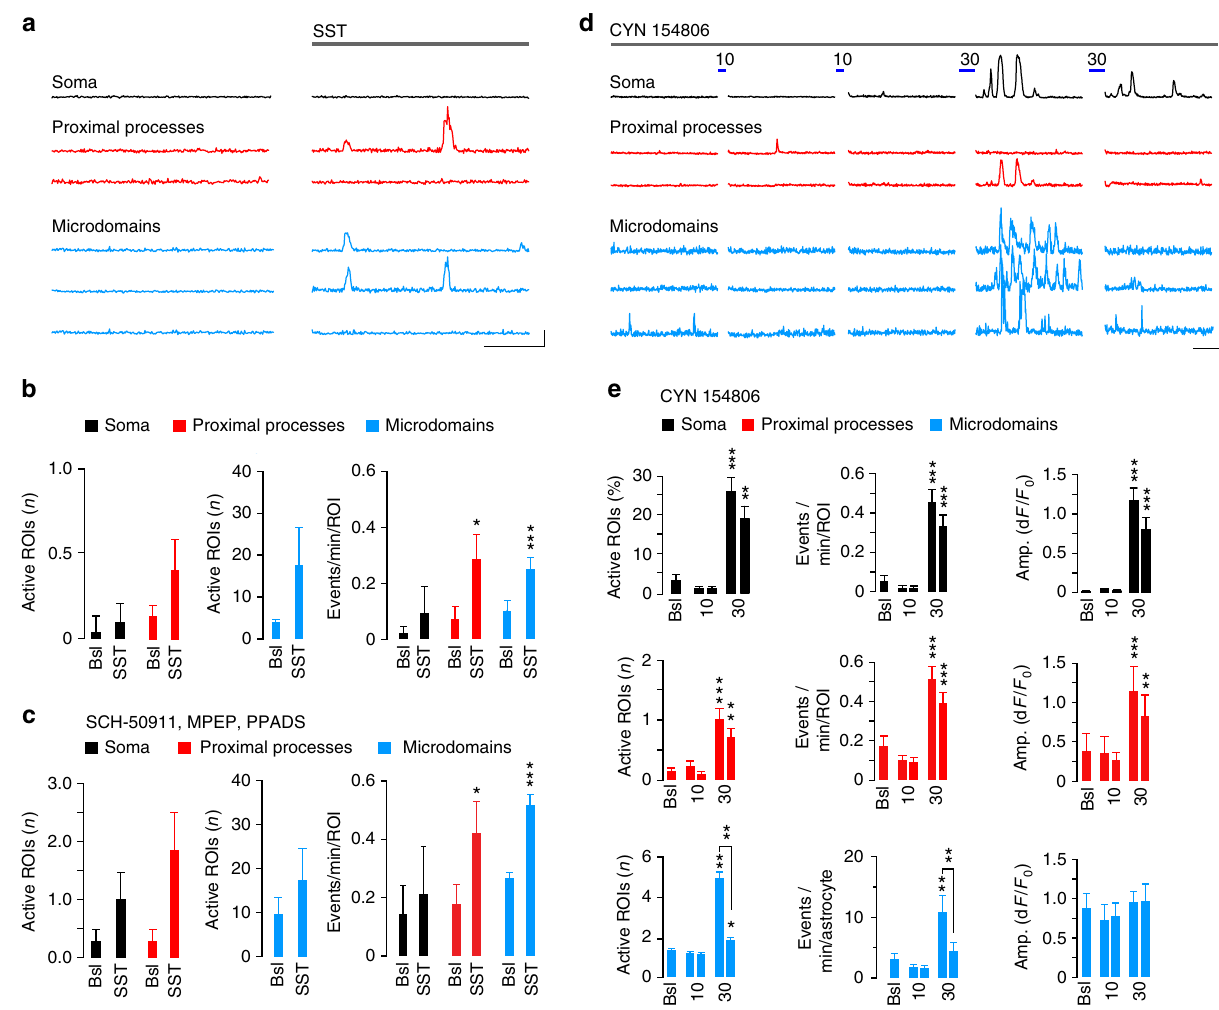
Fig. 6 SST interneuron signaling speci fi city to astrocytes depends on the neuropeptide somastostatin. a Representative traces and b , c quantitative evaluation of GCaMP6f-astrocyte responses to the neuropeptide SST in SSCx slices in the absence (28 astrocytes, 8 slices, 3 mice) or the presence (9 astrocytes, 9 slices, 3 mice) of antagonists of GABA B (SCH50911, 50 µ M), mGlu5 (MPEP, 50 µ M) and purinergic (PPADS, 100 µ M) receptor antagonists and in the continuous presence of TTX (1 µ M). Scale bars, 50 s, 20% d F / F 0 . The response of GCaMP6f-astrocytes is not affected by the mix of receptor antagonists. d Representative Ca 2+ traces of a GCaMP6f-astrocyte before and after subsequent 10 and 30 pulse SST interneuron activations in the presence of 20 μ M CYN 154806. Scale bars, 50 s, 20% d F / F 0 . e Mean number of active ROIs, event frequency and amplitude at soma, proximal processes and microdomains of GCaMP6f-astrocytes (57 astrocytes, 10 slices, 5 mice). Data are represented as mean ±